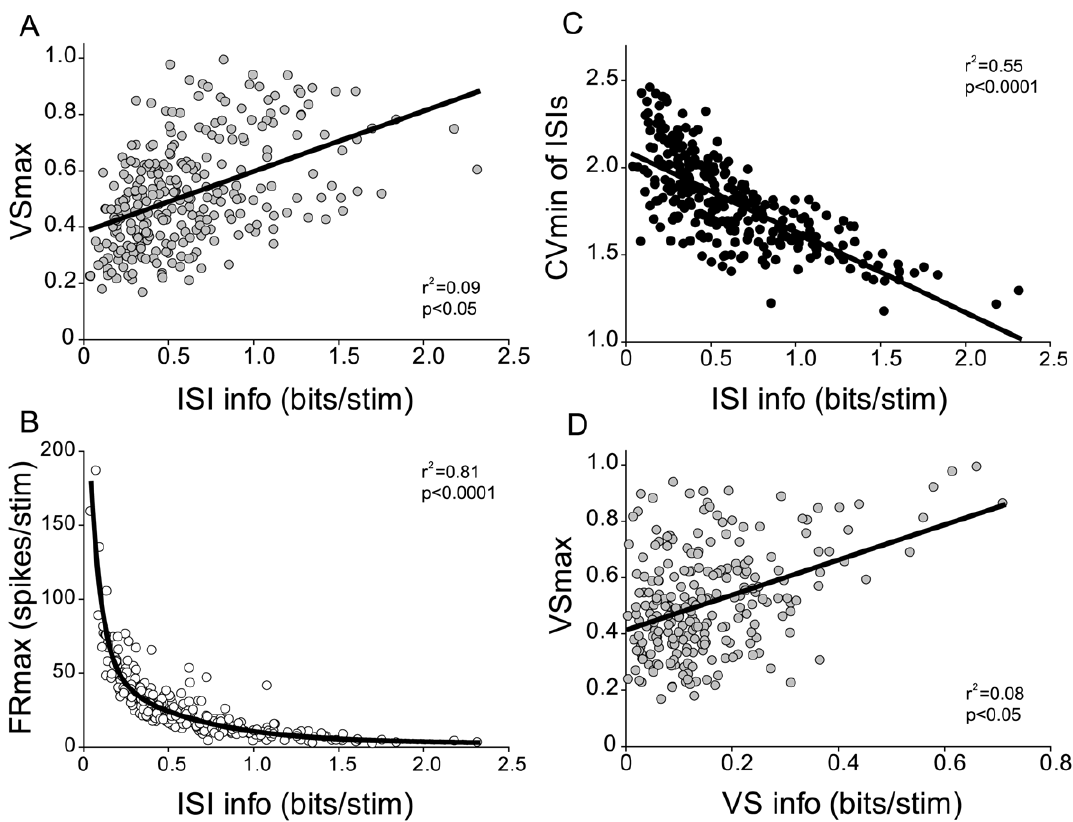
Figure 3. Correlation between information and three temporal response measures. (A) Positive correlation between VS max and ISI info ( p , 0.05). (B) Negative exponential correlation between ISI info and FR max ( p , 0.0001). (C) Negative correlation between ISI info and CV min ( p , 0.0001). (D) Weak positive correlation between VS info and VS max ( p , 0.05).